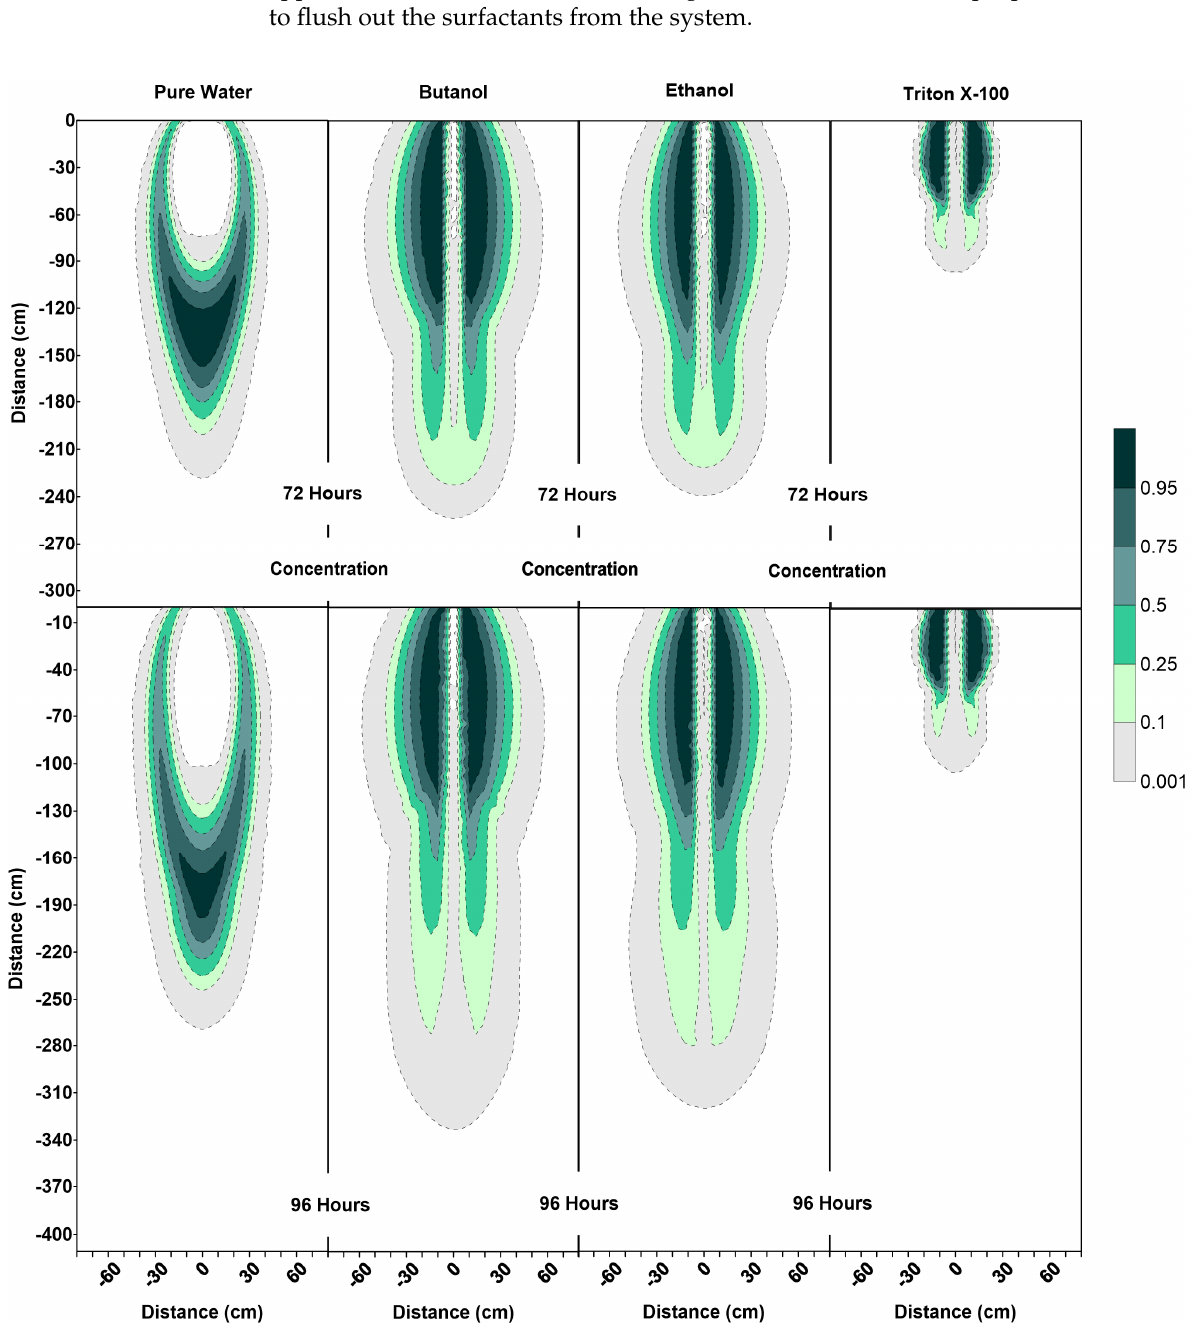
Figure 8. Concentration profiles (for relative concentrations of 1.0) at 72 h and 96 h for pure water, butanol, ethanol and Triton X ‐ 100 solutions.